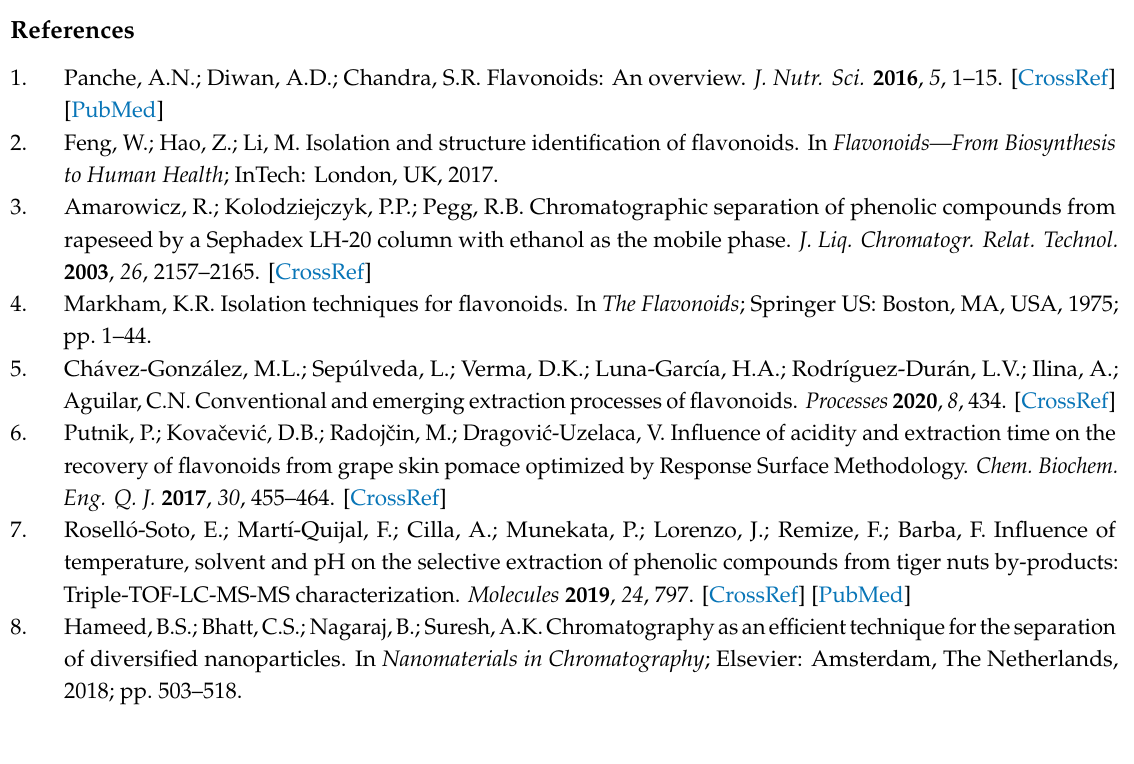
Table S1. Isolated or purified flavonoid derivatives by utilizing Sephadex ® LH-20 from diverse plant